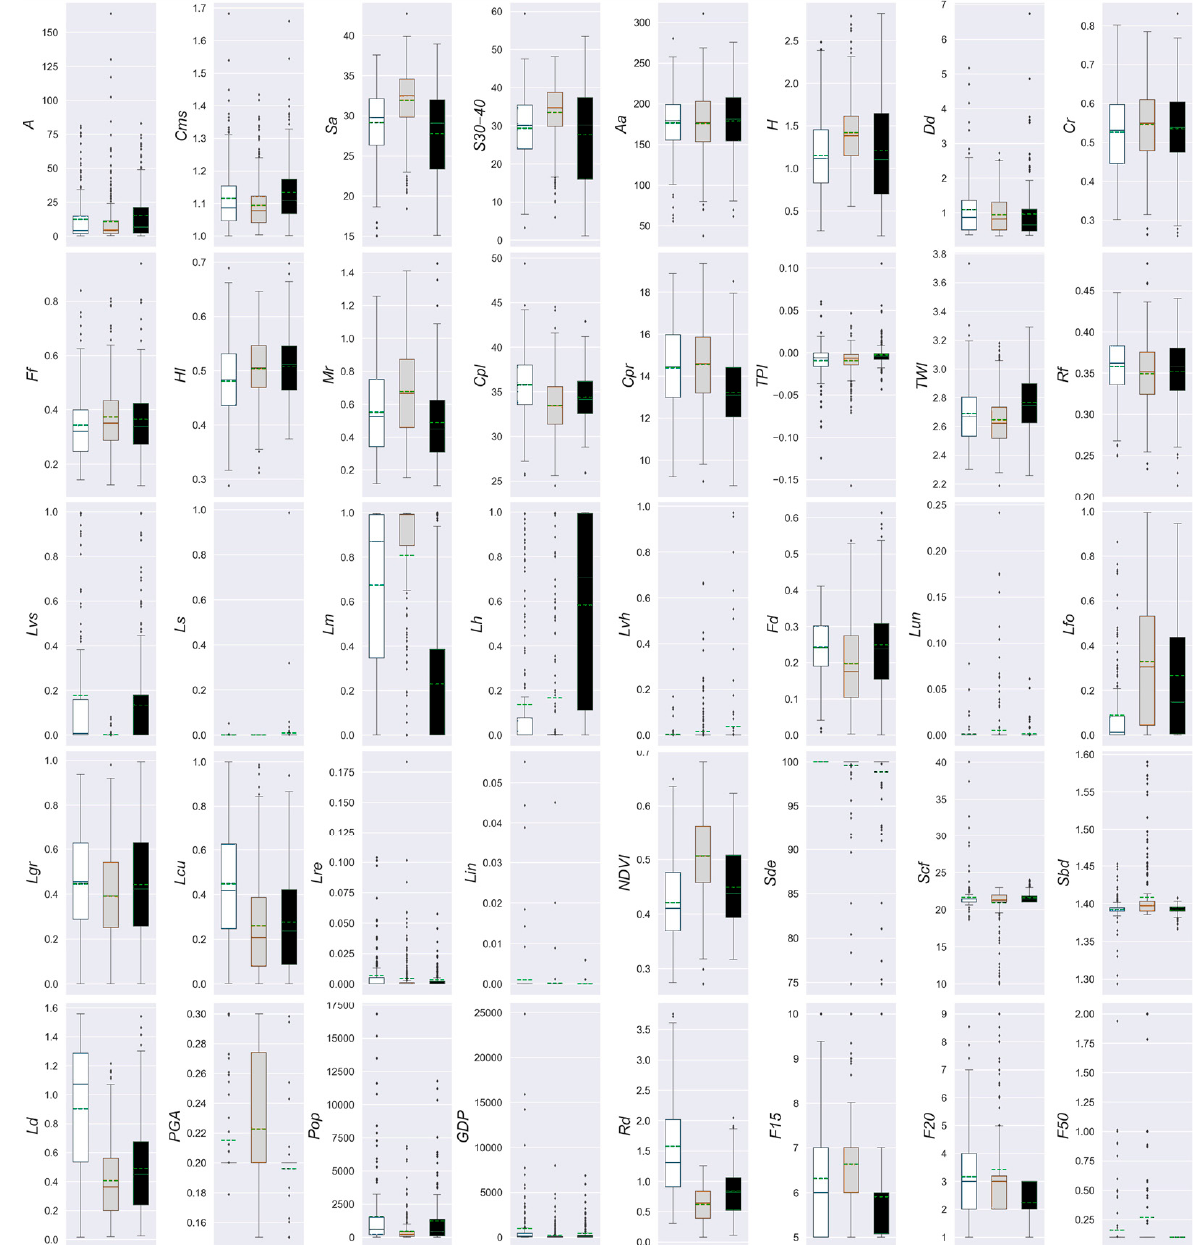
Figure 7. Box plots of the factors in different debris flow frequency zones. (White indicates the high zone; grey indicates the moderate zone; and black indicates the low zone).